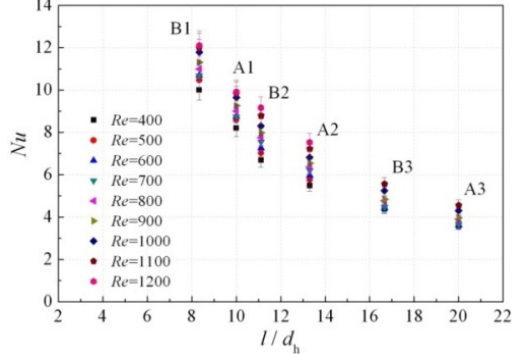
Figure 6. Nusselt number variation with l / d h , Va = 200.